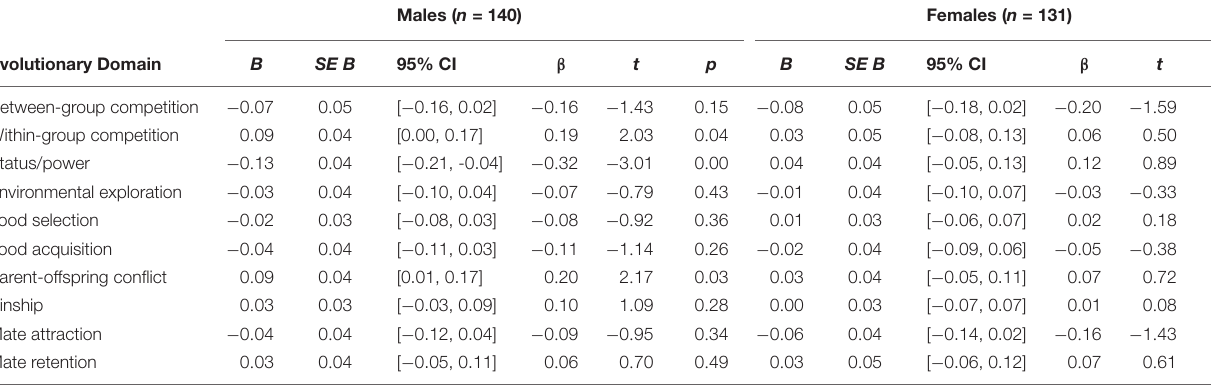
TABLE 7 | Multiple regression analysis for risk perception-context predicting risk-taking behaviors. Males ( n = 140)